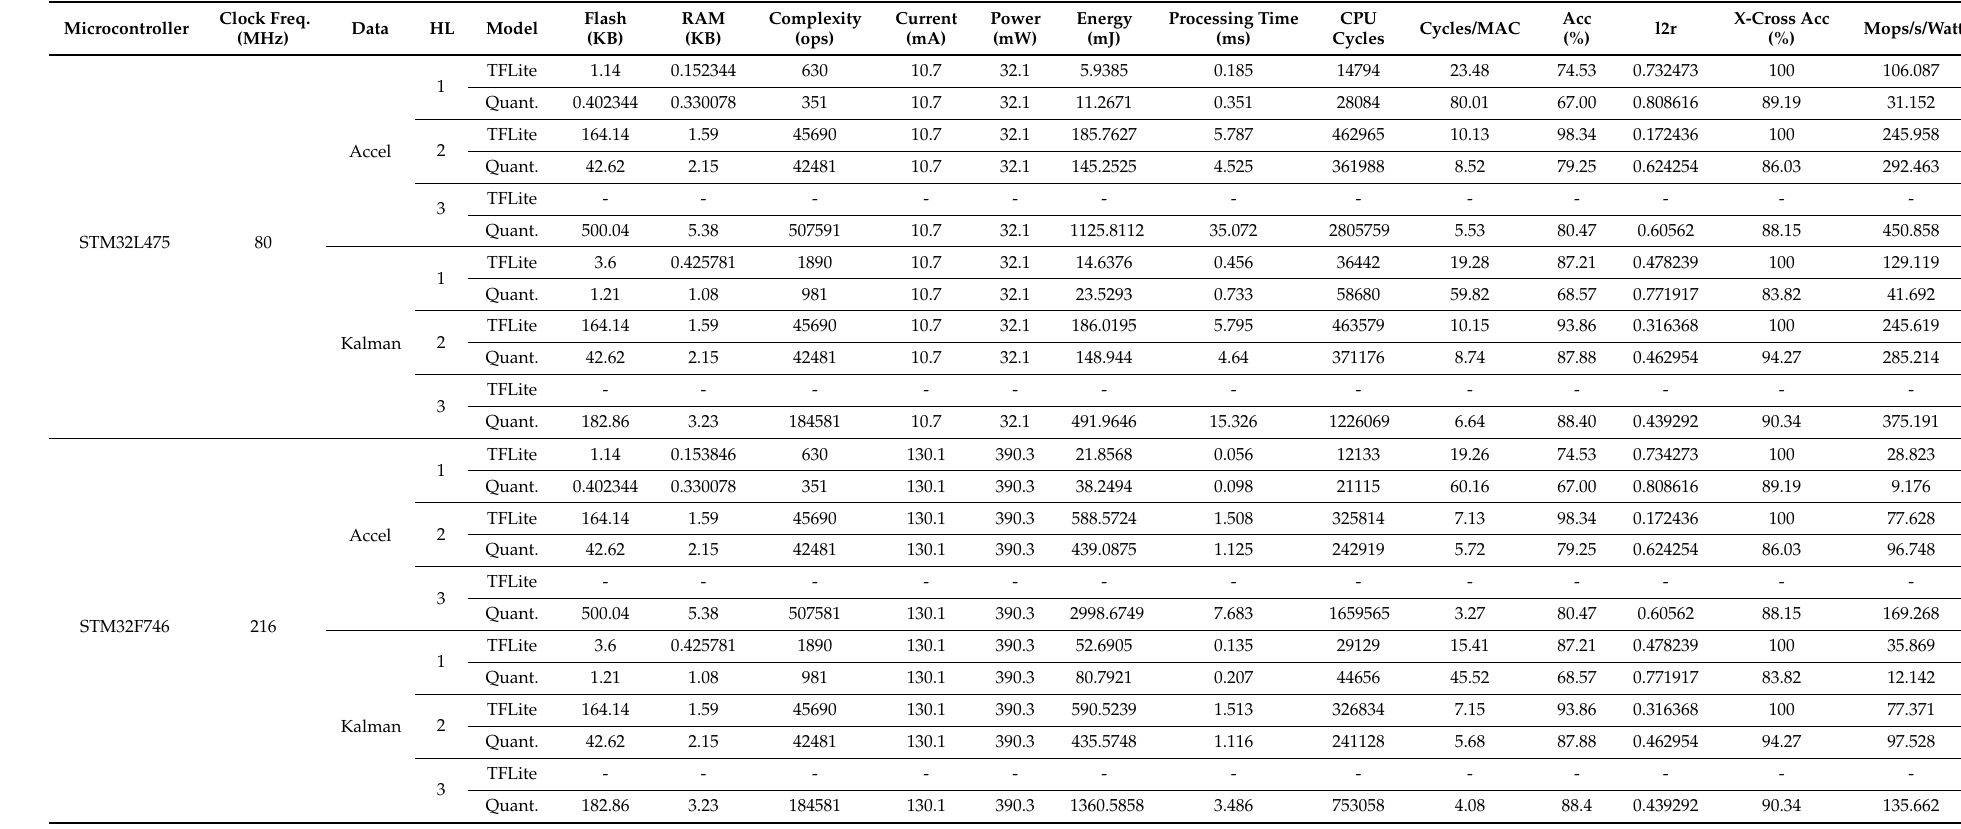
Table A3. Results obtained for each of the implemented models on the two microcontrollers considered. The complexity of the models in terms of number of operations is also presented.